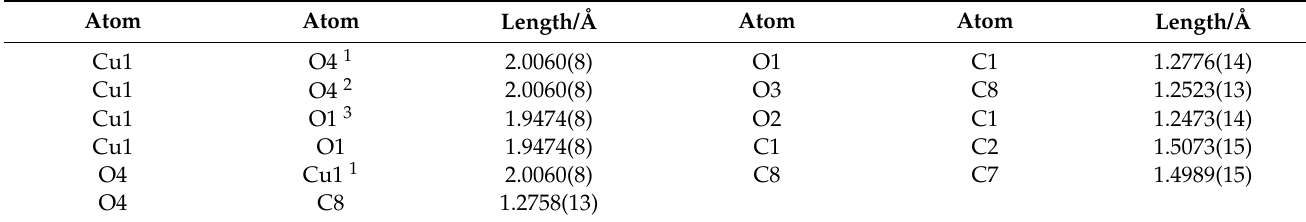
Table 1. Bond Lengths for III .